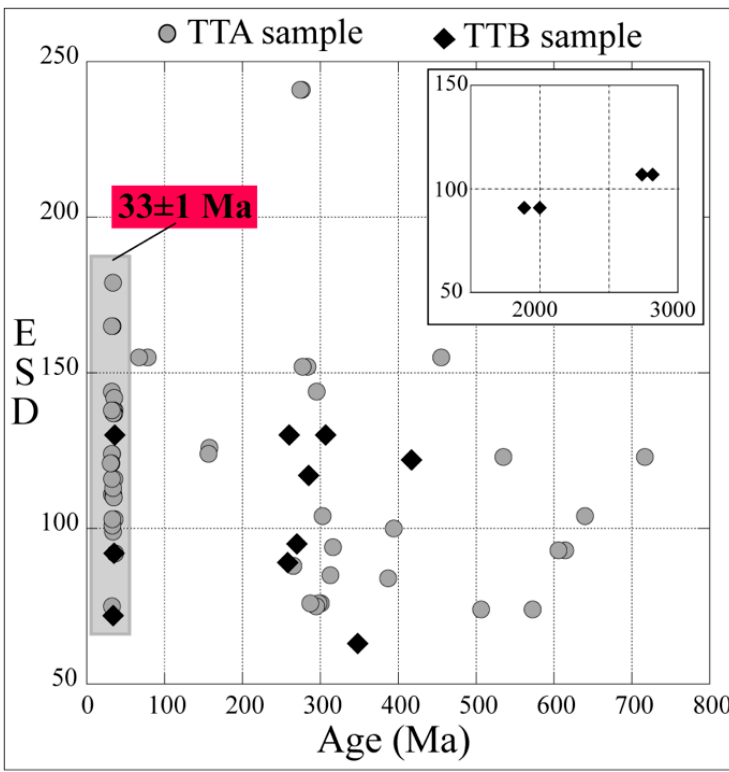
Figure 8. Equivalent spherical diameter (ESD µ m) of the detrital zircon grains vs. the U-Pb ages in the TTA and TTB sandstone samples. The distribution of ages is independent from the grain-size of zircons. Ages > 1.4 Ga in TTB sample derived from the 206 Pb/ 207 Pb ratios (inset of figure).